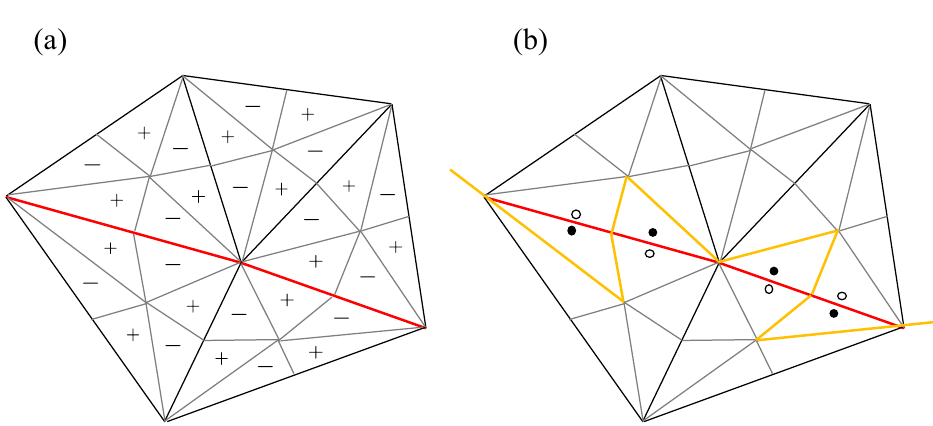
Figure 2 . (a): the signs of triangles near the orientation reversing wall, which is represented as a red line. (b): assignment of Grassmann variables on the wall speci(cid:12)es a deformation of the wall that intersects the wall transversally at